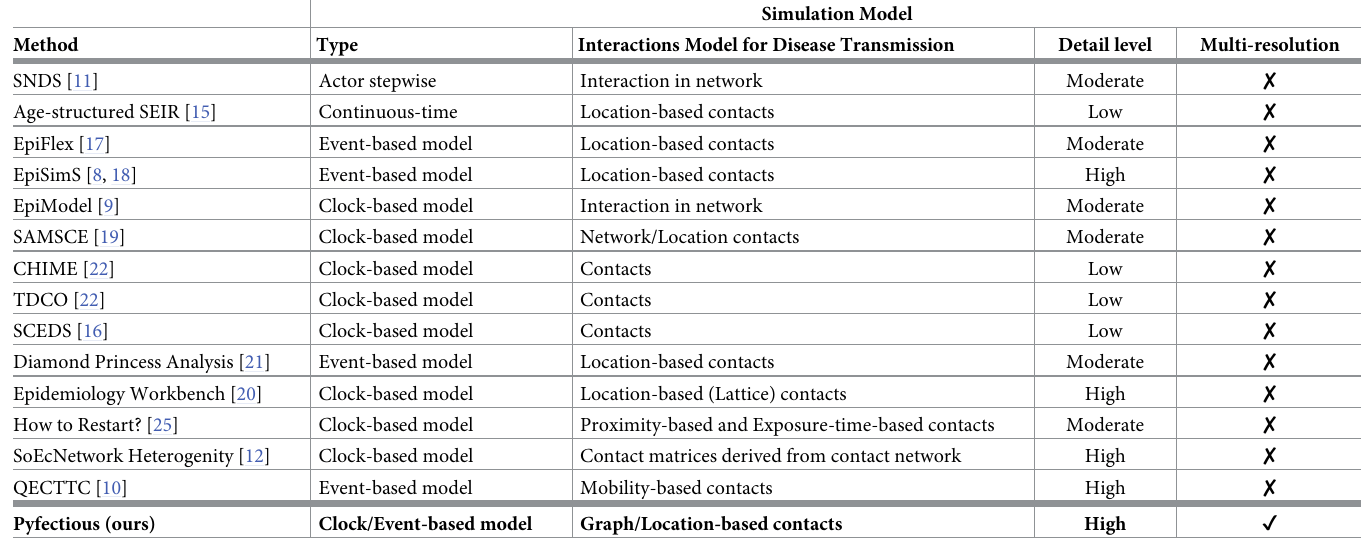
Table 2. Comparing the employed methods to simulate the dynamics of epidemic disease in various epidemic simulation